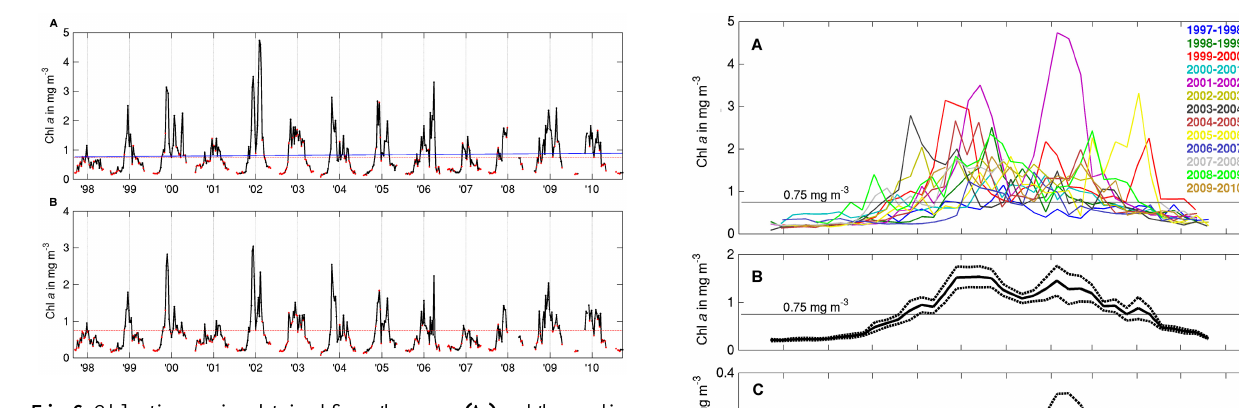
Fig. 6. Chl a time series obtained from the mean (A) and the median (B) of all Chl a values available from eight-day composites of the typical bloom area between September 1997 and September 2010. In (A) the regression line calculated along time is illustrated in blue. In both cases, as pixels with no data were excluded, we distinguish values that were obtained from more (black) or less (red) than 30% of all pixels contained in the typical bloom area. Between 9 Jan- uary and 28 March 2008 no SeaWiFS data were available. Chl a concentrations are expressed inmgm − 3 . Vertical grid-lines indicate the first week of each year. The dashed red horizontal lines denote 0.75mgm − 3 .